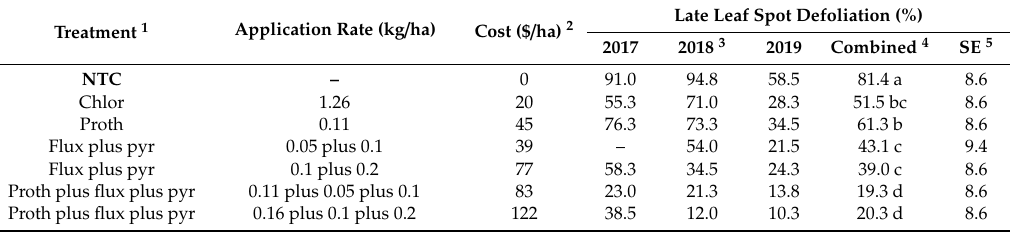
Table 1. Peanut canopy late leaf spot defoliation associated with fungicide treatments from field experiments conducted in Blackville, SC, from 2017 to 2019.